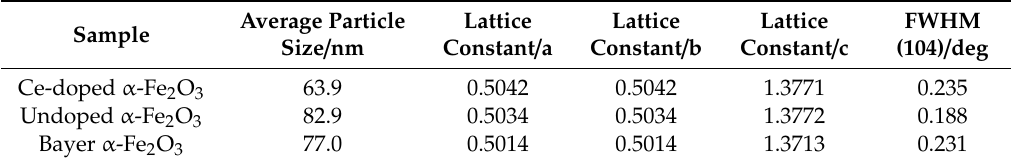
Figure 2. Comparison of (104) and (110) peaks from the XRD patterns. Table 1. Average particle size and lattice constant of nanoparticles a